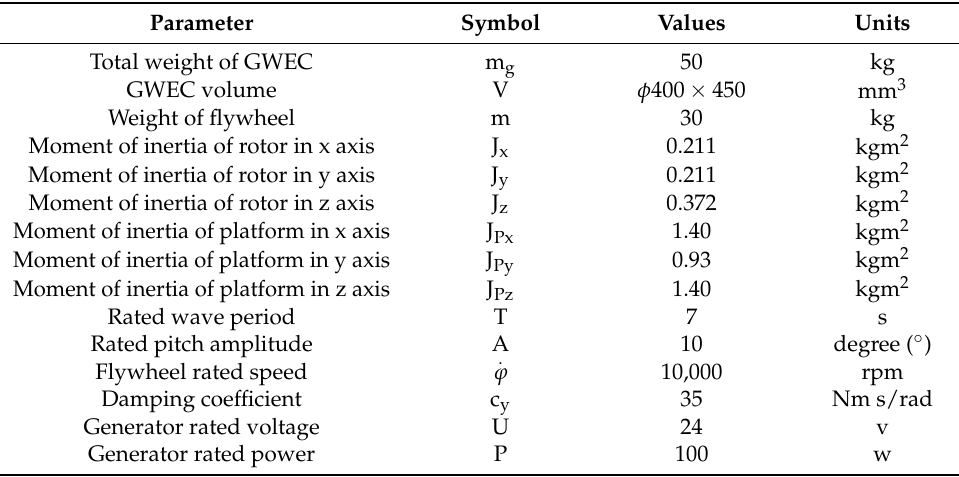
Figure 6. Operation of the gyroscope wave power generation system. Table 1. Specification of the prototype